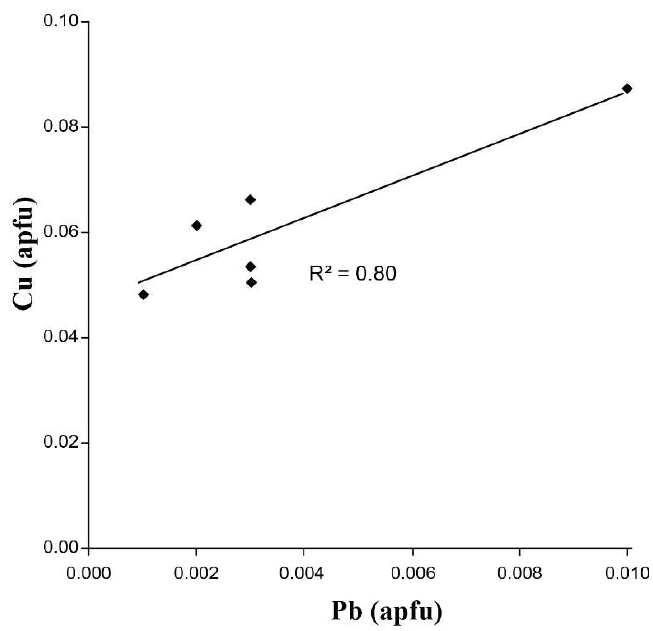
Figure 8. Correlation between Cu 2 + and Pb 2 + in Cu-bearing tourmalines from the Mulungu mine, Rio Grande do Norte, Brazil (samples from